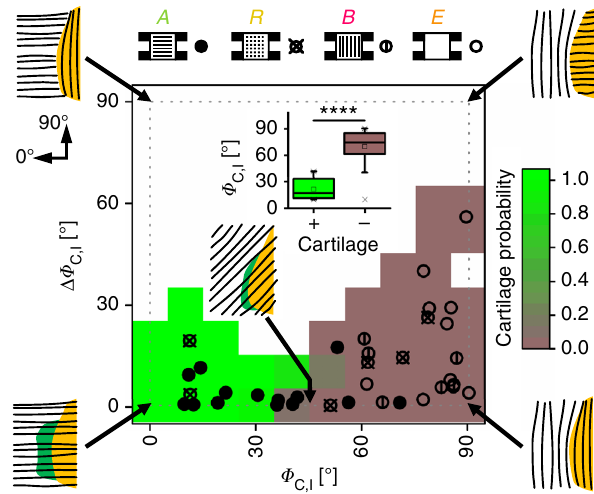
Fig. 6 Dependency of cartilage incidence on collagen fi ber orientation at the mineralization front. Data points in heatmap represent all in vivo specimens with Φ C,I indicating the primary direction of collagen fi bers in the non-mineralized matrix (0° = bone axis) and Δ Φ C,I indicating the difference in orientation between non-mineralized and mineralized matrix. Full circles represent specimens with scaffold A, crossed circles scaffold R, circles with vertical line scaffold B, and empty circles empty controls E. Green and light brown background colors indicate high and low probability for cartilage, respectively; white background without data points. Pictograms illustrate collagen fi ber orientation (black lines) at the mineralization front. Boxplot insert highlights the correlation between low values of Φ C,I and the occurrence of cartilage. Boxplot shows the median, 25th, and 75th percentile values (horizontal bar, bottom, and top bounds of the box), whiskers indicate 1.5-fold IQR, open squares indicate means, crosses represent max./min. values. Signi fi cance via Mann – Whitney test (two-sided); **** p <